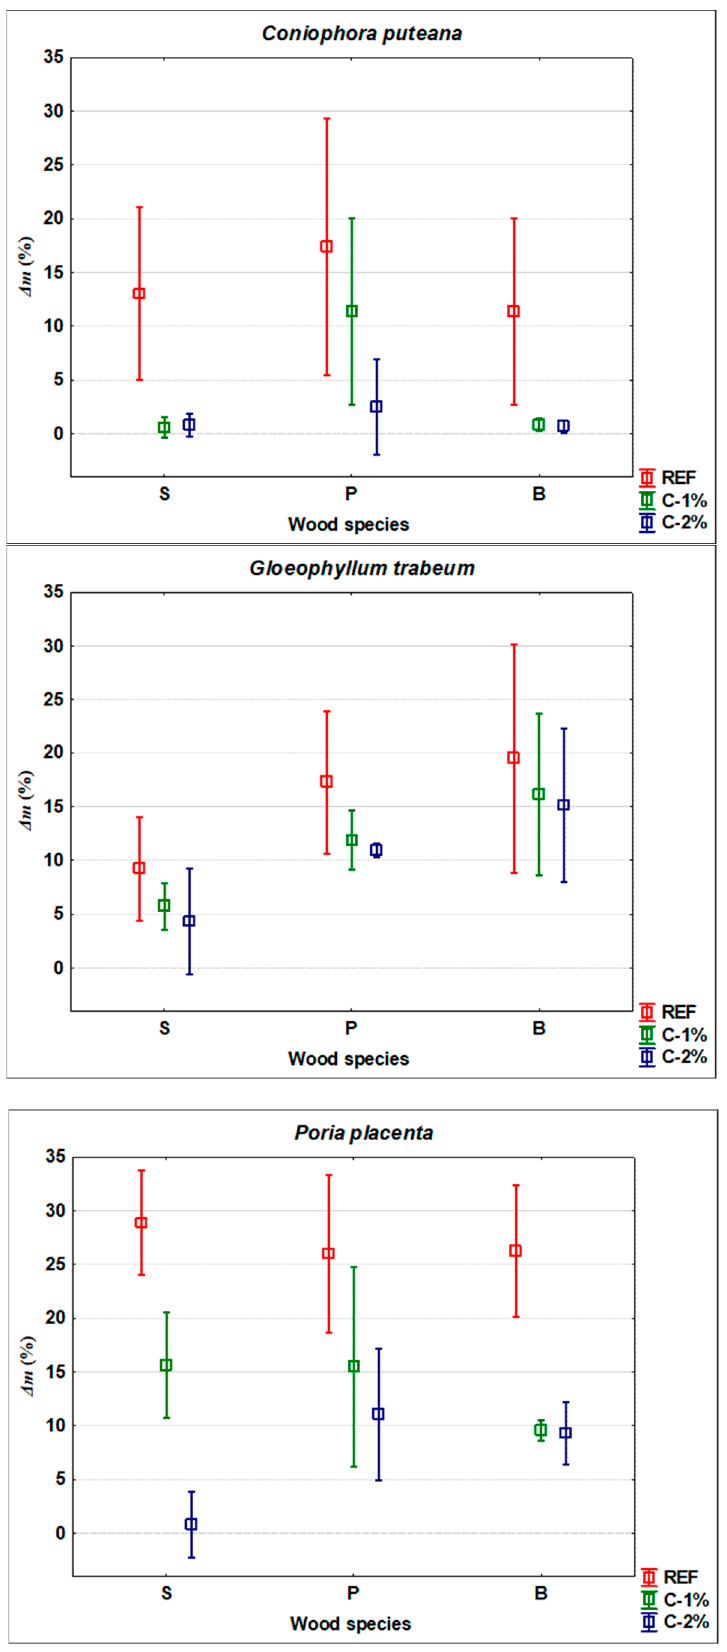
Figure 3. Degradation by wood-destroying fungi.